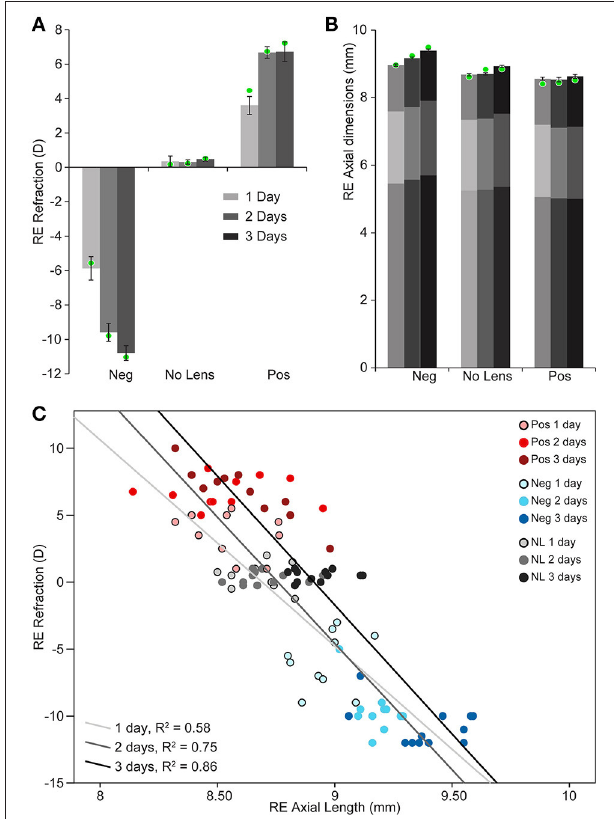
FIGURE 1 | Graphs showing refraction and axial dimensions during myopia and hyperopia induction, and normal development. (A) Mean ( ± SE) right eye refraction. (B) Mean ( ± SE) right eye axial length (measured from the cornea to the outer limiting membrane of the retina). Mean anterior and vitreous chamber depths are shown as darker shaded regions at the top and bottom, respectively, of axial length measures. These biometric values are for n = 10–12 chicks per condition. Mean refraction and axial length for the subset of these chicks chosen for sequencing are shown as green circles superimposed on the graphs in “A” ( n = 4 per condition selected for strong and cohesive phenotypic responses). (C) Scatter plot showing the relationship between refractive error and axial length (Pearson’s correlation coefficient for all data points: r = − 0.846, p <